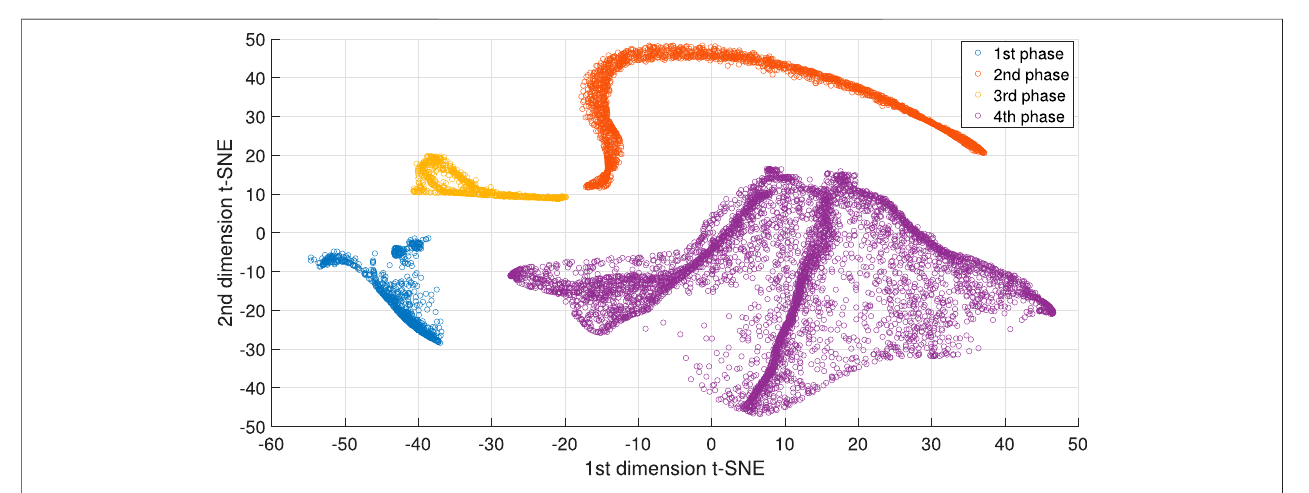
FIGURE 7 | Manifold learning via SVM-regression for the Pensim